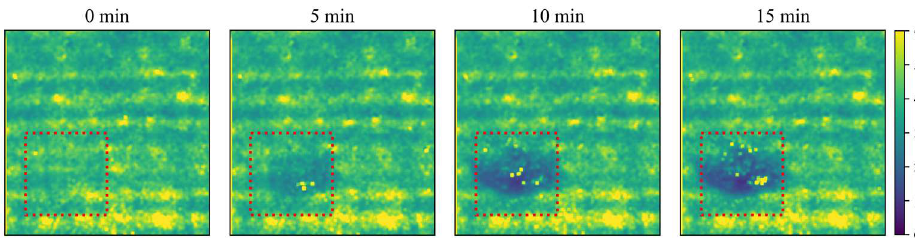
Figure 8. Changes in the reduced scattering coefficient of bruised tissue of ‘crown’ pears. The red box indicates changes in tissue optical properties in the bruised area of the pear.